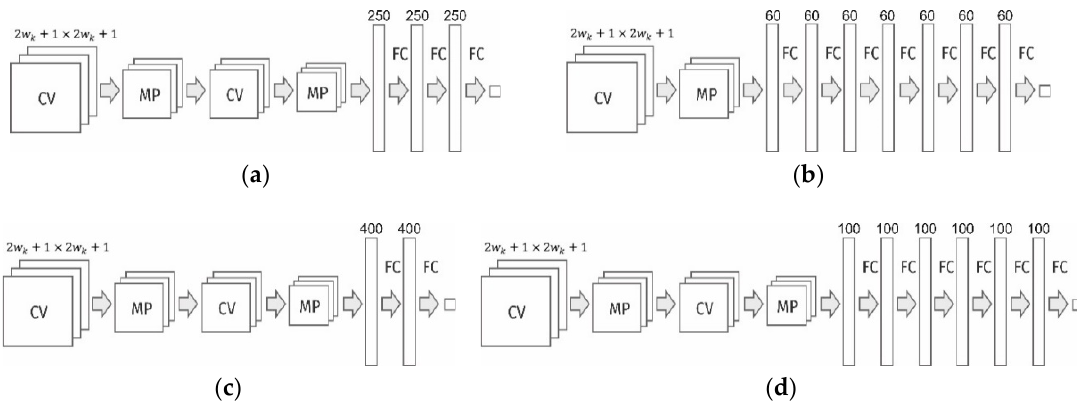
Figure 2. Best by accuracy/speed ratio neural network architectures. ( a )—neural network with 2 convolutional layers and 3 intermediate fully connected layers; ( b )—network with single convolutional layer and the stack of 7 small fully connected layers; ( c )—network with 2 convolutional layers and 2 big fully connected layers (this model showed the best performance); ( d )—model with 2 convolutional layers and the stack of 6 intermediate fully connected layers; CV—convolutional layers; MP—max-pooling layers; FC—fully connected layers.